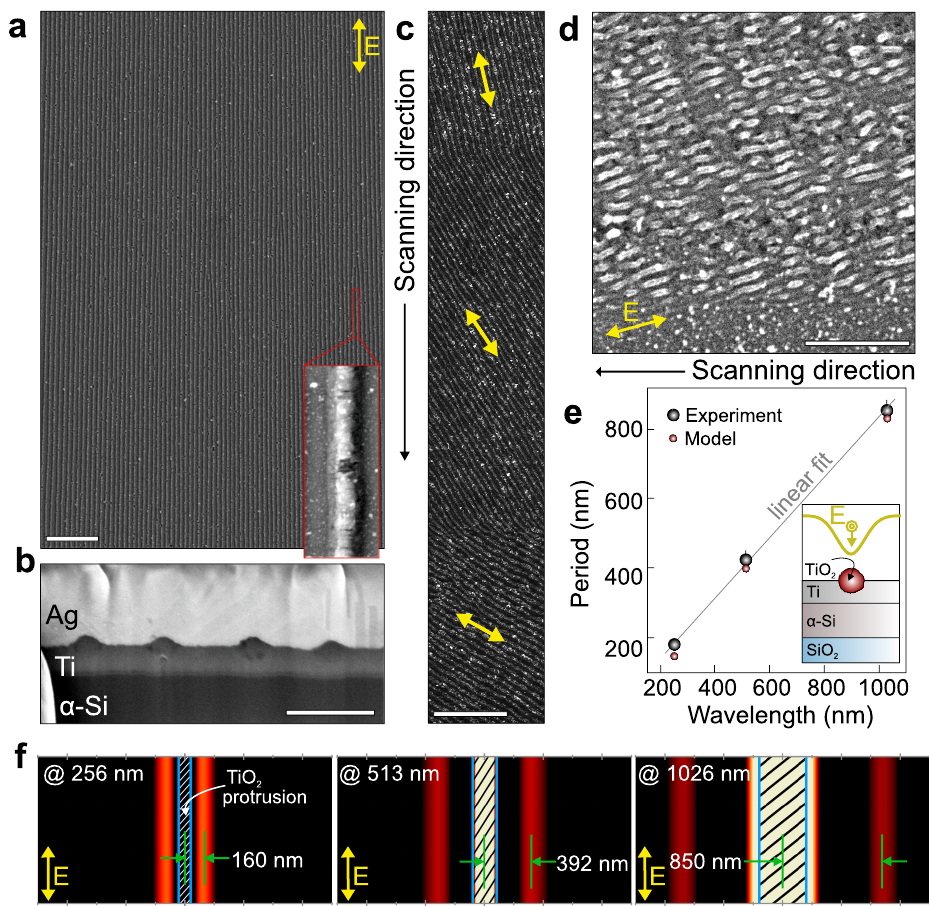
Figure 3. ( a ) Top-view SEM image of TLIPSS structures produced above the 90-nm thick Ti film in air at λ = 513 nm ( F = 50 mJ/cm 2 , v = 3 µm/s). Inset shows the enlarged view of the single TiO 2 protrusion. ( b ) SEM images of cross-sectional FIB cut made perpendicularly to the TLIPSS orientation. ( c ) Top-view SEM image of similar TLIPSS produced by step-like variation of the polarization direction in the process of sample scanning with a laser beam. ( d ) SEM image of the TLIPSS produced at λ = 256 nm ( F = 35 mJ/cm 2 , v = 1 µm/s). A double-headed arrow in the SEM images indicates the polarization direction. Scale bars in the SEM images indicate 5 µm ( a , c ) and 500 nm ( b , d ). ( e ) Measured (black markers) and calculated (red markers) averaged TLIPSS period vs. incident laser wavelength used for their fabrication. Inset: schematic illustration of the modeled geometry. ( f ) 2D intensity profiles calculated near the Ti surface containing the central TiO 2 protrusion at different incident laser wavelengths. Color scale was adjusted for better visibility. Shaded rectangles indicate the area occupied by the